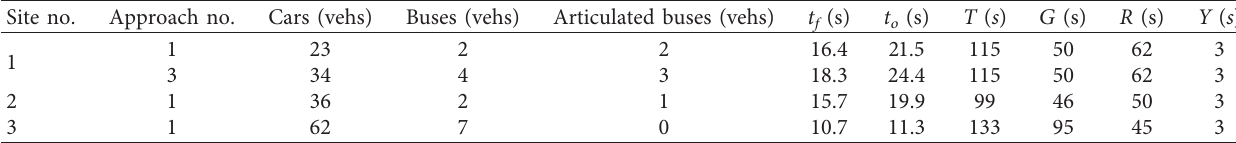
Table 2: Used traffic data of straddling work zone in signalized intersection.